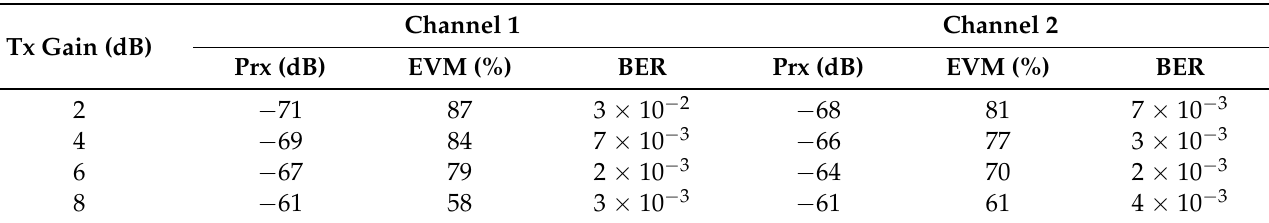
Table 1. The 2 × 2 near-field MIMO BER and EVM measurements in the metal enclosure. Maximum power gain of AGC was set to 60 and the RF frequency was 5.6 GHz.